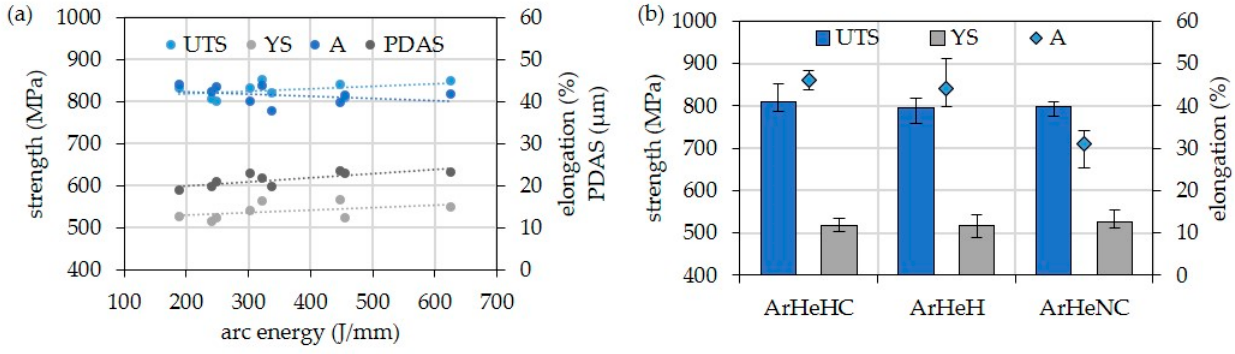
Figure 14. Results of tensile tests at RT of walls of HY282 depended on ( a ) arc energy and ( b ) shield- ing gas.